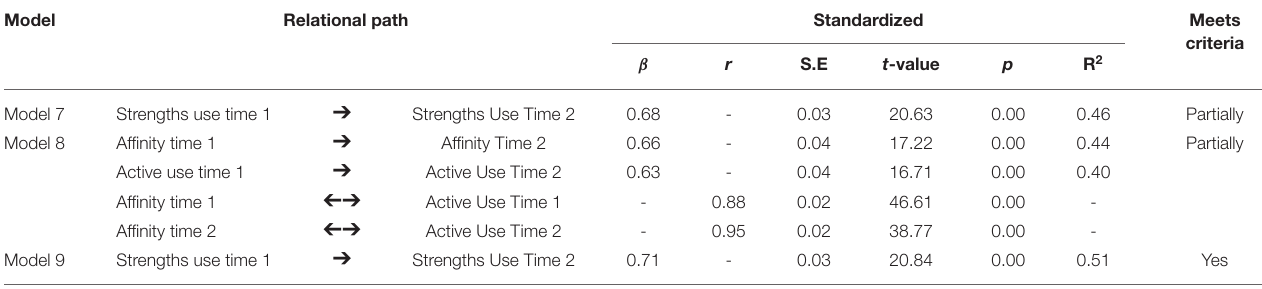
TABLE 6 | Longitudinal confirmatory factor analyses: regressive paths and covariances between time 1 and time 2.